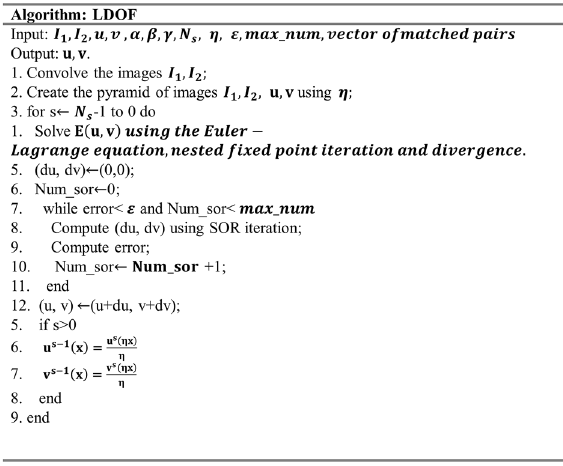
Figure 21. Pseudo-code of